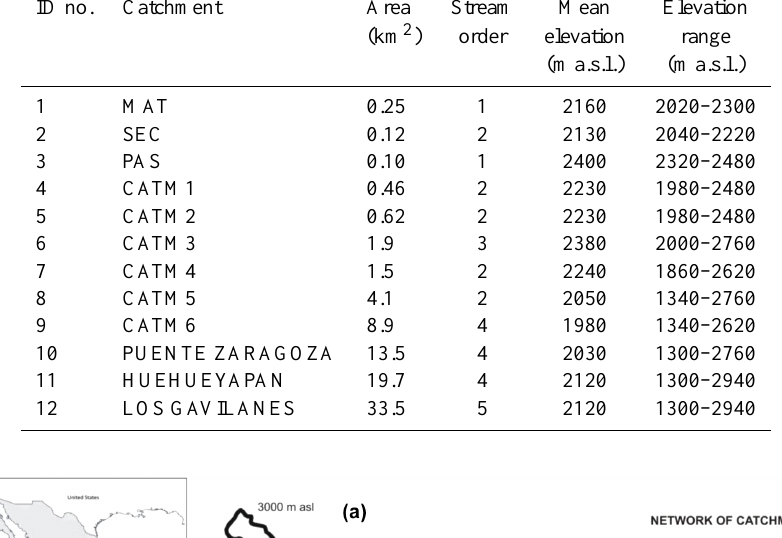
Table 1. Topographic characteristics of the 12 catchments (0.1–34km 2 ) investigated.